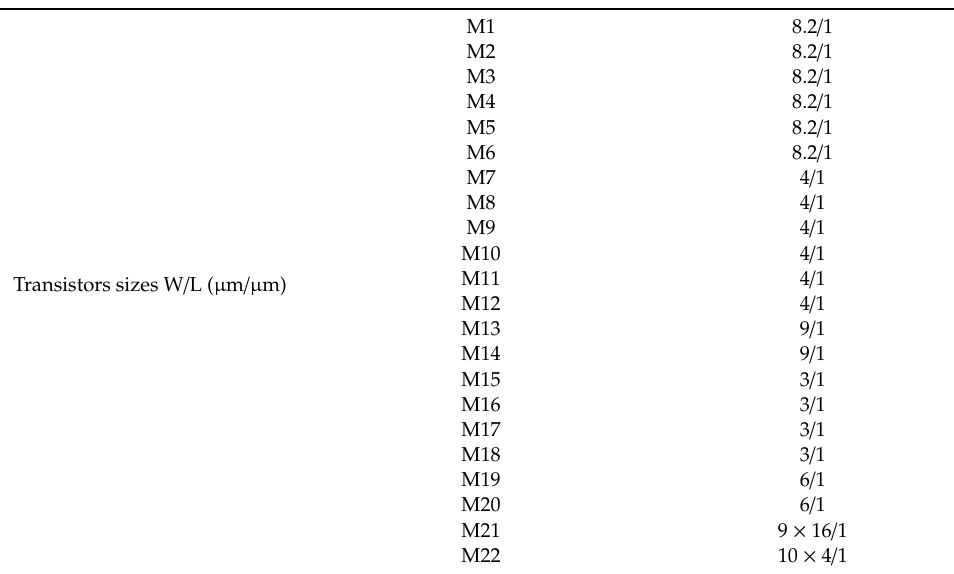
Figure 7. DAC schematic ( a ) DAC; ( b ) rail-to-rail buffer. Table 4. Component sizes and simulated performance specifications.